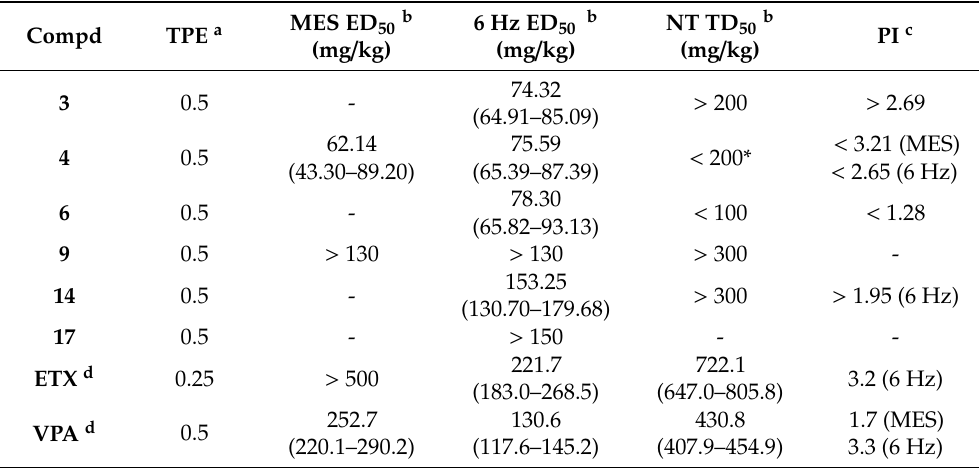
Results are represented as mean ± SEM at 95% confidence limit. A dash indicates—not tested. a Time to peak e ff ect. b MES—maximal electroshock test; 6 Hz—psychomotor seizure test (32 mA); NT—neurotoxicity—rotarod